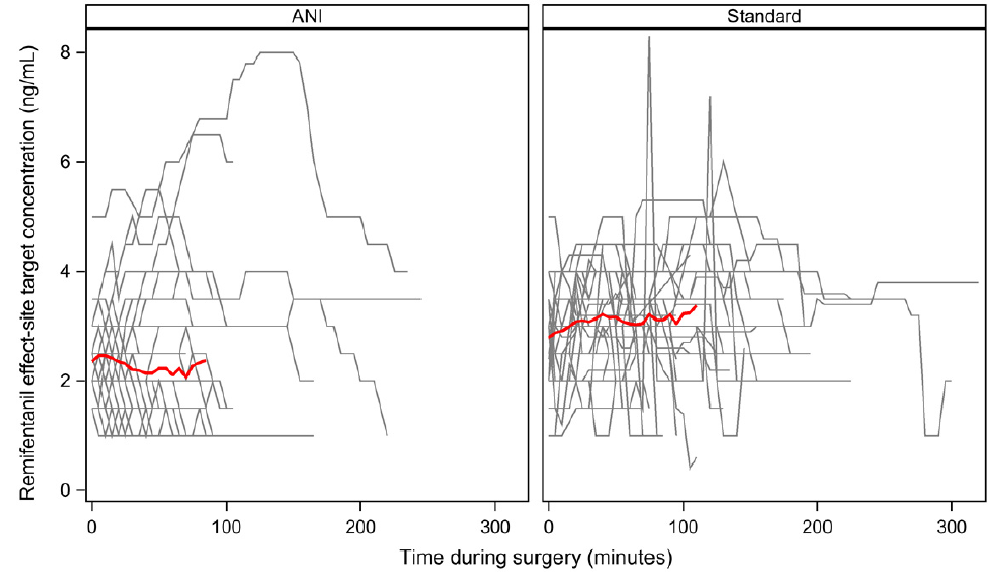
Figure 2. Individual evolution of remifentanil effect-site target concentration in the ANI (38 lines; left) and Standard group (40 lines; right). Each line represents a patient. Red lines represent the means.